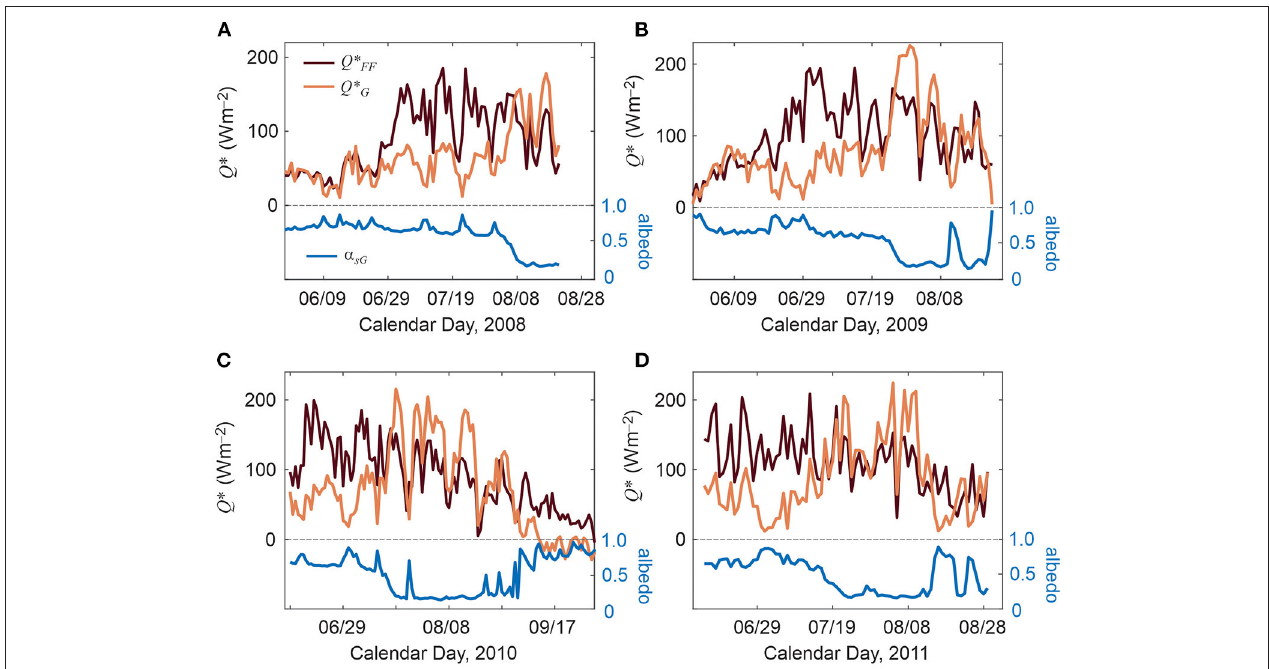
FIGURE 8 | Mean daily net radiation, Q*, at the glacier forefield AWS and the glacier AWS for the (A) 2008, (B) 2009, (C) 2010, and (D) 2011 melt seasons at Kwadacha Glacier. The rapid decrease in mean daily glacier surface albedo, plotted in blue indicates the transition from seasonal snow to exposed glacier ice each